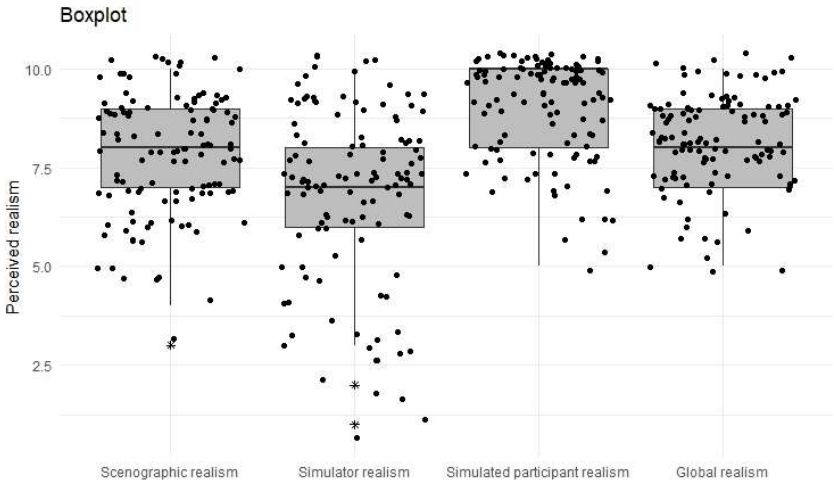
Figure 2. Box plot of realism perceived by students. Tests used Kruskal–Wallis test, ANOVA test for repeated means = 1.24 × 10 − ²³.